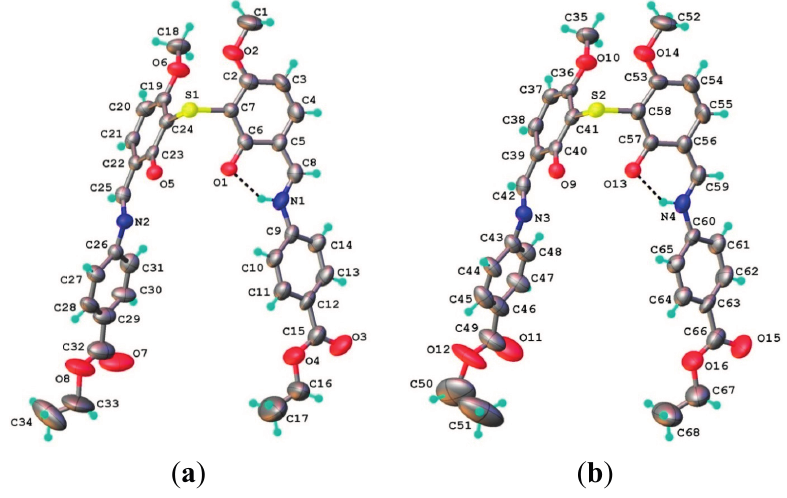
Figure 7. Structure of the two ligands ( L 2 S) in the complex cation [Cu 2 (L 2 S) 2 (ClO 4 )(H 2 O)] +